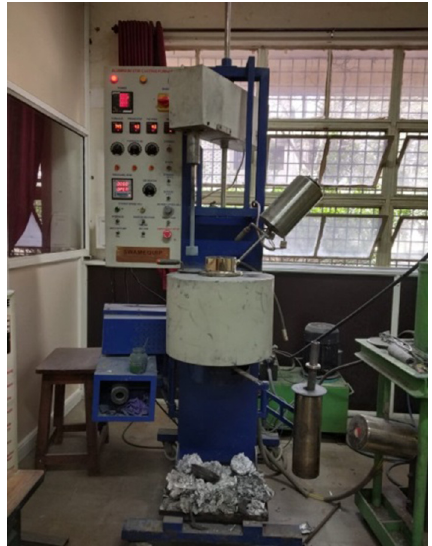
Fig. 1. Stir casting setup.